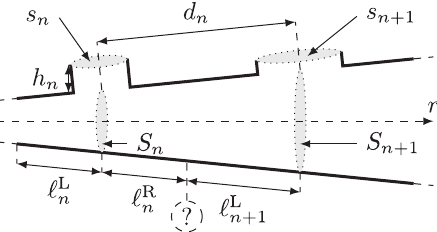
Figure 6. Schematic of a tonehole P -cell. Interhole spacing þ ‘ L d n = ‘ R is unambiguously de fi ned. n n þ 1